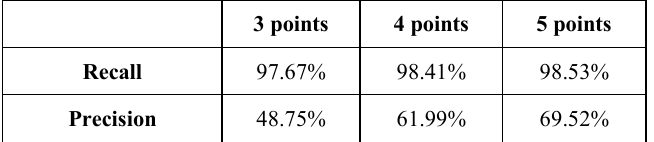
Table 1. Results of applying several metrics to the trained network for different input length. 3 points 4 points 5